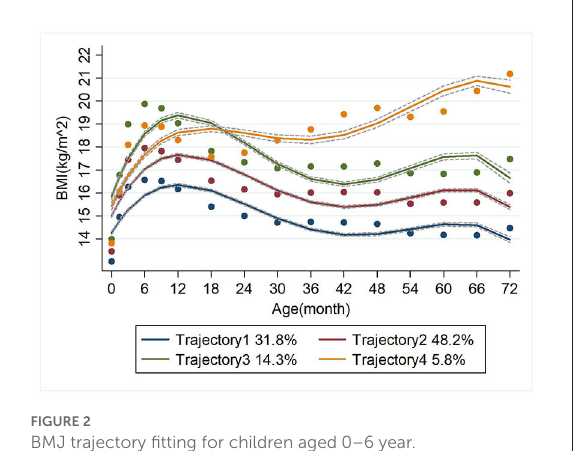
FIGURE2 BMJ trajectory fitting for children aged 0–6 year.